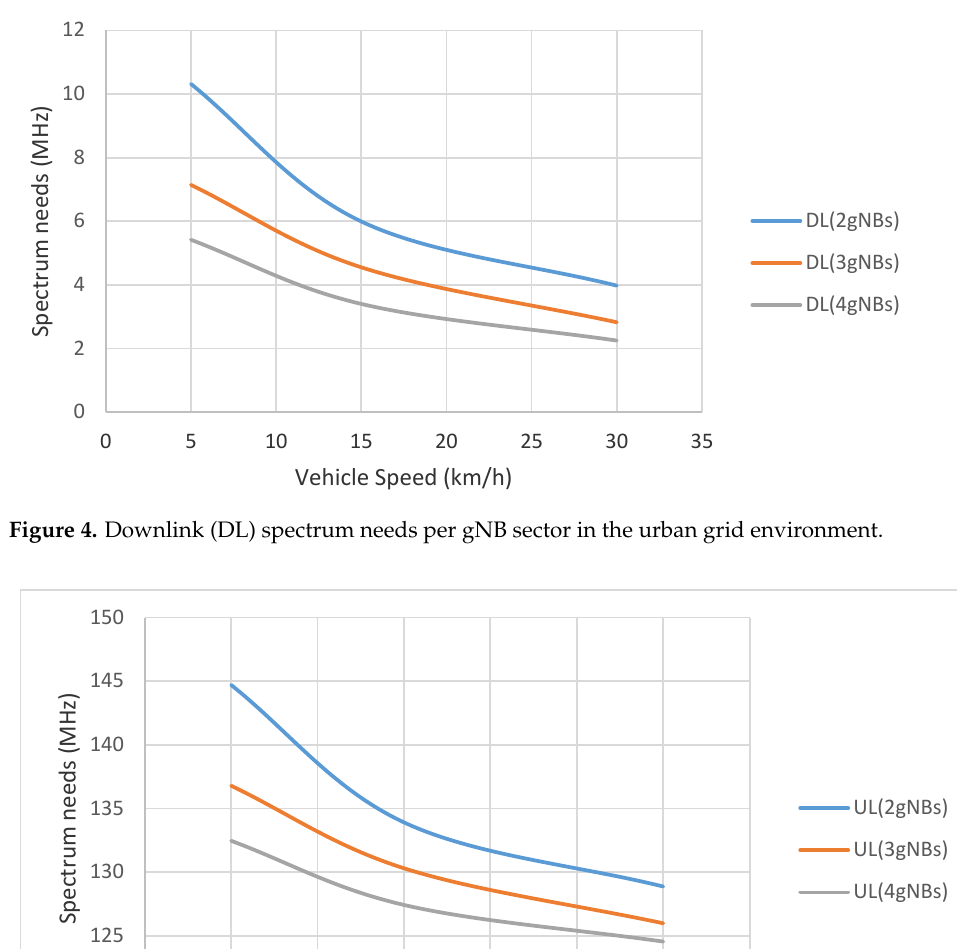
Figure 4. Downlink (DL) spectrum needs per gNB sector in the urban grid environment.